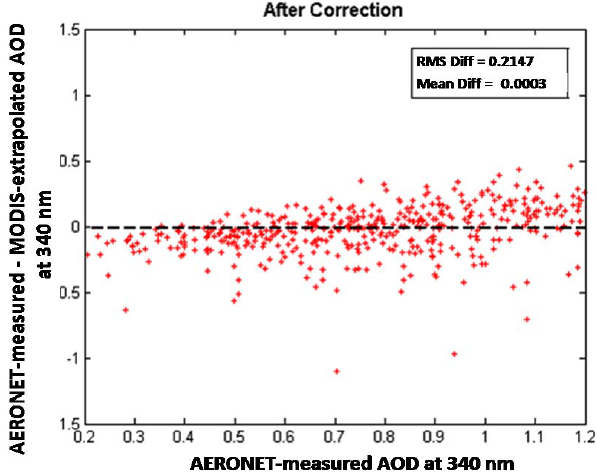
Fig. 4. Regional distribution of aerosol SSA.